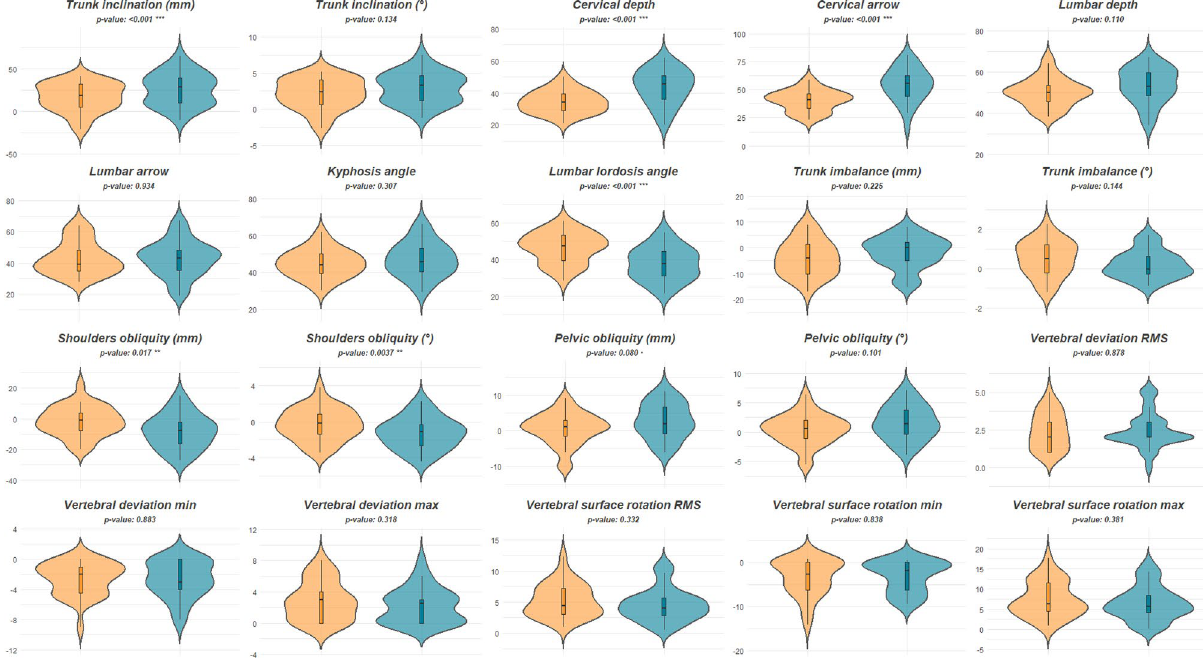
Figure 2. Violin plots for the sagittal (first two lines) and coronal (last three lines) parameters. Orange represents the female group; blue represents the male group. Each violin plot shows inside the boxplot and the correspondent p-value, · p < 0.1, * p < 0.05, ** p < 0.01, *** p <